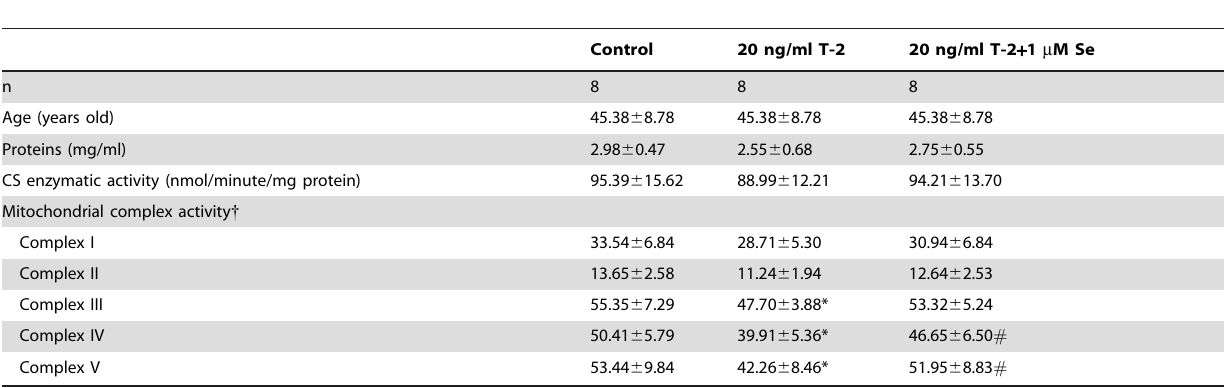
Table 1. Values of mitochondrial respiratory chain complexes in cultures of normal chondrocytes treated with 20 ng/ml T-2 toxin for 5 days.